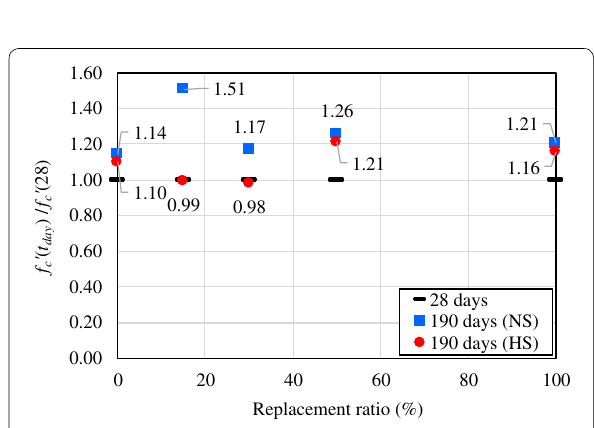
Fig. 7 Development of the splitting tensile